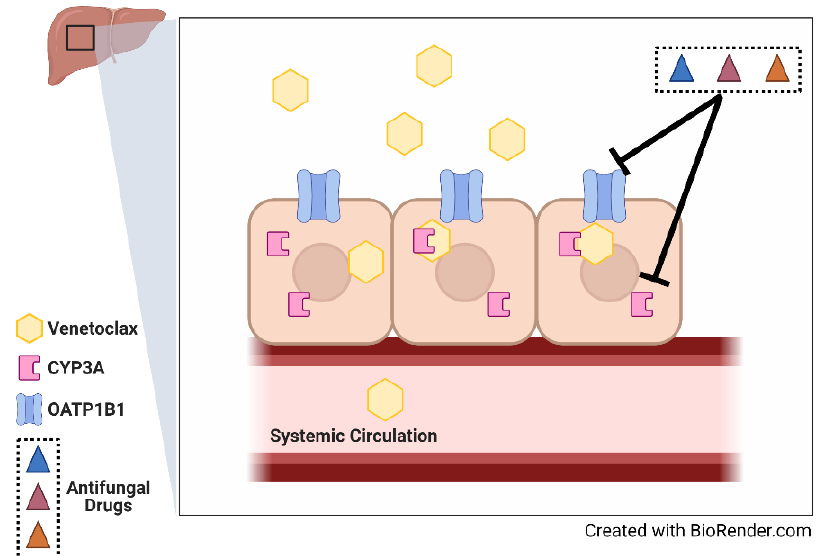
Figure 5. Summary figure. Both CYP3A and OATP1B1 contribute to the pharmacokinetics of venetoclax and are inhibited by antifungal drugs. Solid lines represent knowledge gaps clarified by our experiments.